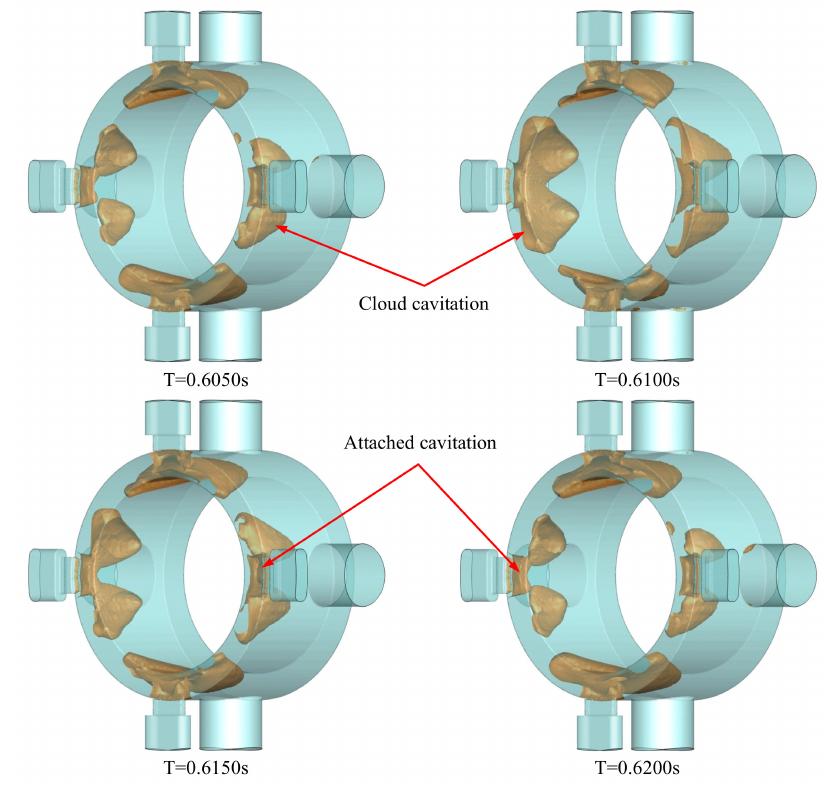
Figure 5. Morphological variation of cavitation in the valve